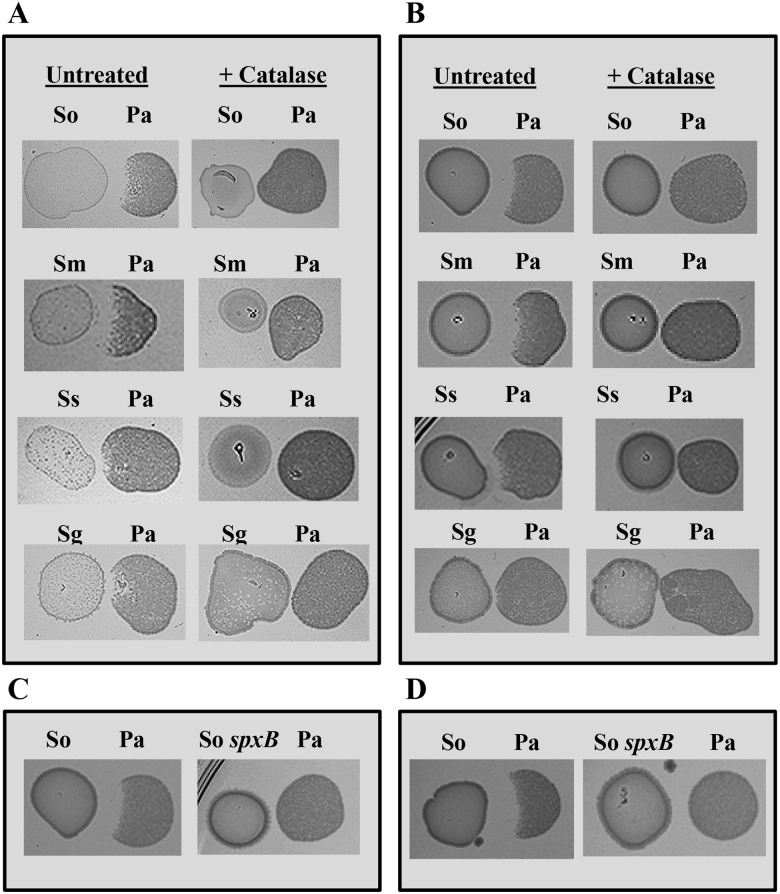
Antagonism of P. aeruginosa growth by pioneering streptococcal colonisers.Bacterial strains—Pa, P. aeruginosa CF2004; Sm, S. mitis NCTC 12261T; Sg, S. gordonii NCTC 7865T; Ss, S. sanguinis NCTC 7863T; So, S. oralis ATCC 35037T, and So spxB, S. oralis ATCC 35037T
spxB mutant. Streptococcal spp were inoculated onto the agar surface as pioneer colonisers and incubated for 24 h at 37°C h in an A and C) aerobic (+10% CO2) and B and D) anaerobic atmosphere before CF2004 cultures were adjacently inoculated as secondary colonisers and grown for a further 24 h at 37°C h in an aerobic atmosphere (+10% CO2).